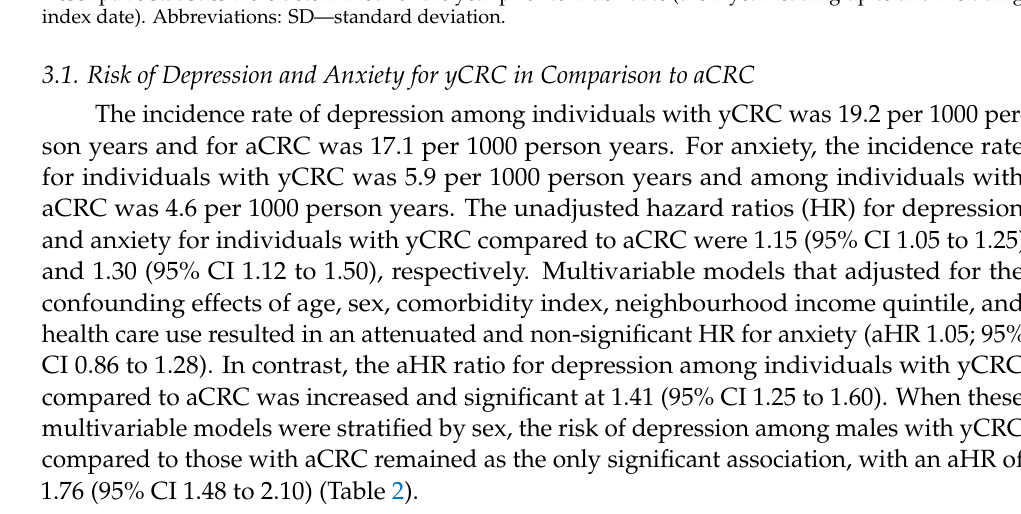
Table 2. Risk of depression and anxiety in individuals diagnosed with young-onset colorectal